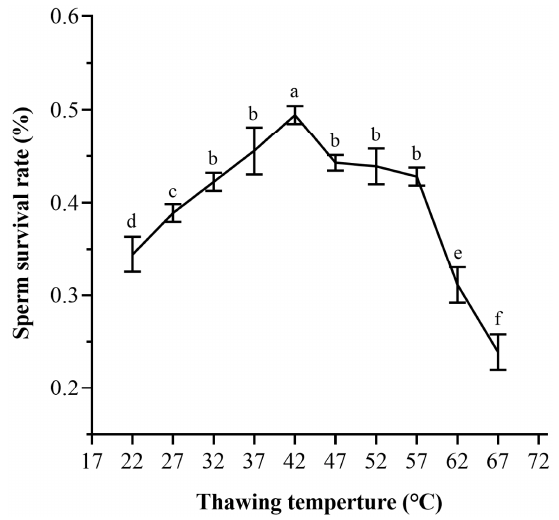
Figure 5. The survival rates of sperm of P. trituberculatus after different resuscitation temperatures on cryopreservation. The same letter means that the difference is not significant ( p > 0.05), and different letters mean that the difference is significant ( p < 0.05) ( n = 60).